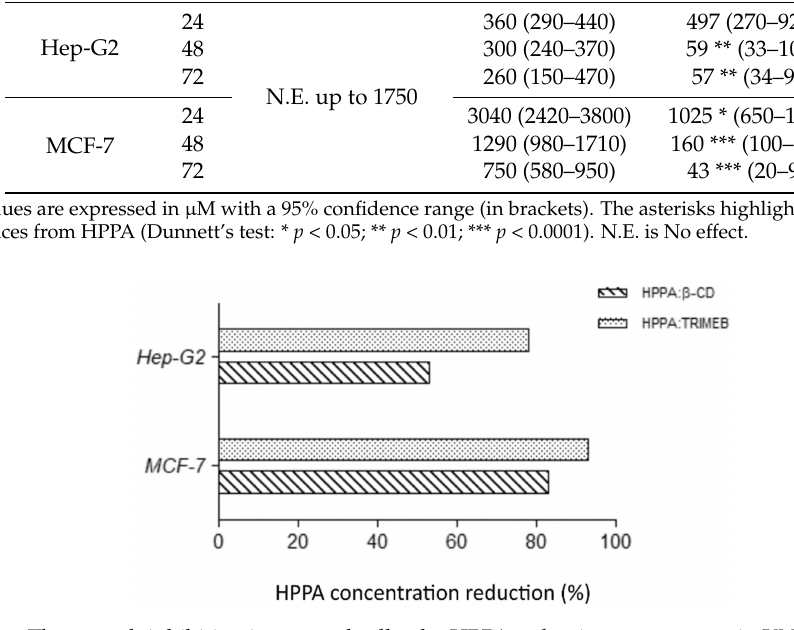
Figure 8. The growth inhibition in tumoral cells: the HPPA reduction percentages in KNDs in Hep-G2 and MCF-7 at 72 h of exposure to induce 50% of the cellular growth inhibition.